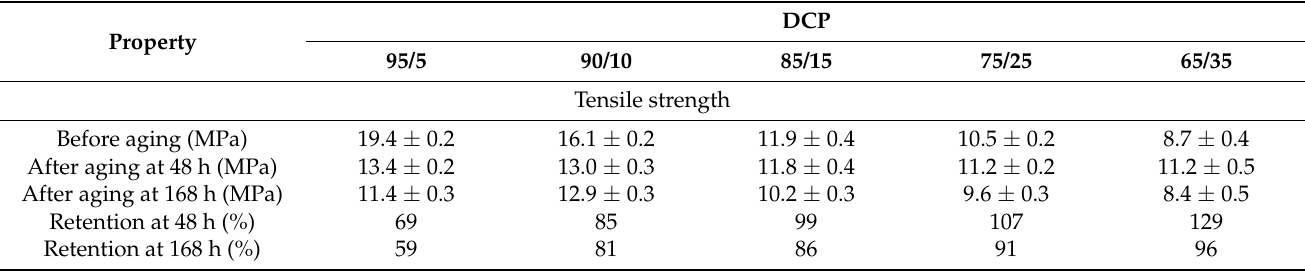
Table 4. Heat aging of NR/r-NBR blends prepared with P and S/DCP crosslinking